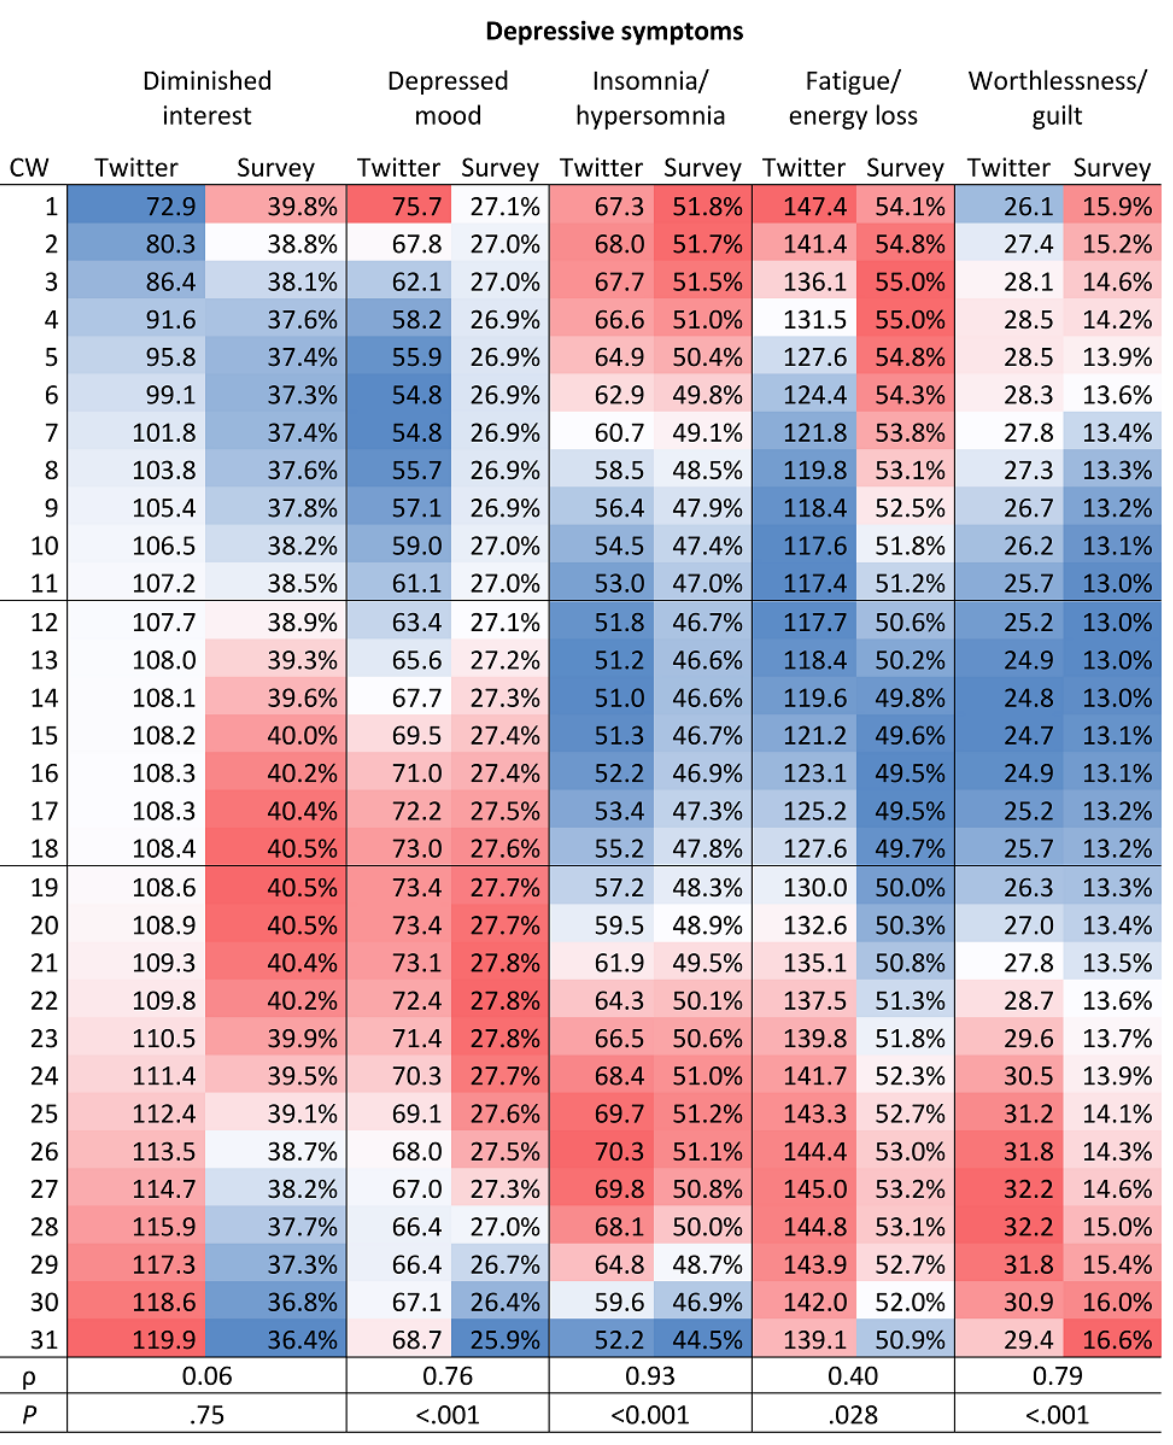
Figure 3. Predictive margins of the smoothed curves of depressive symptoms in the Twitter and survey data by CW from January to August 2020 and the Spearman rank correlation results. Color shading: white represents the mean values, dark blue indicates the lowest values, and dark red indicates the highest values. CW: 1-11 “before,” 12-18 “during,” and 19-31 "after" the German social contact ban. CW: calendar